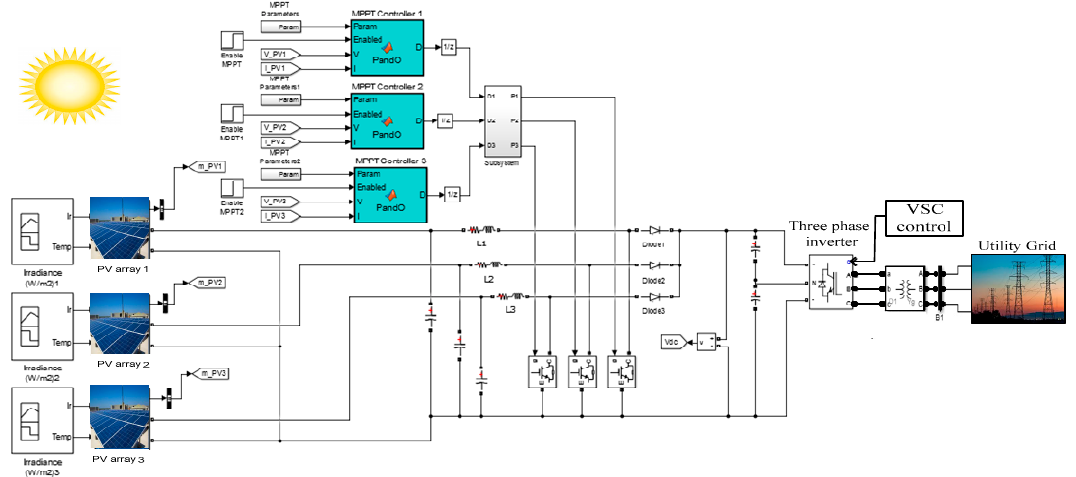
Figure 4. Multi-PV arrays with interleaved boost converter (IBC) interfaced the utility grid.